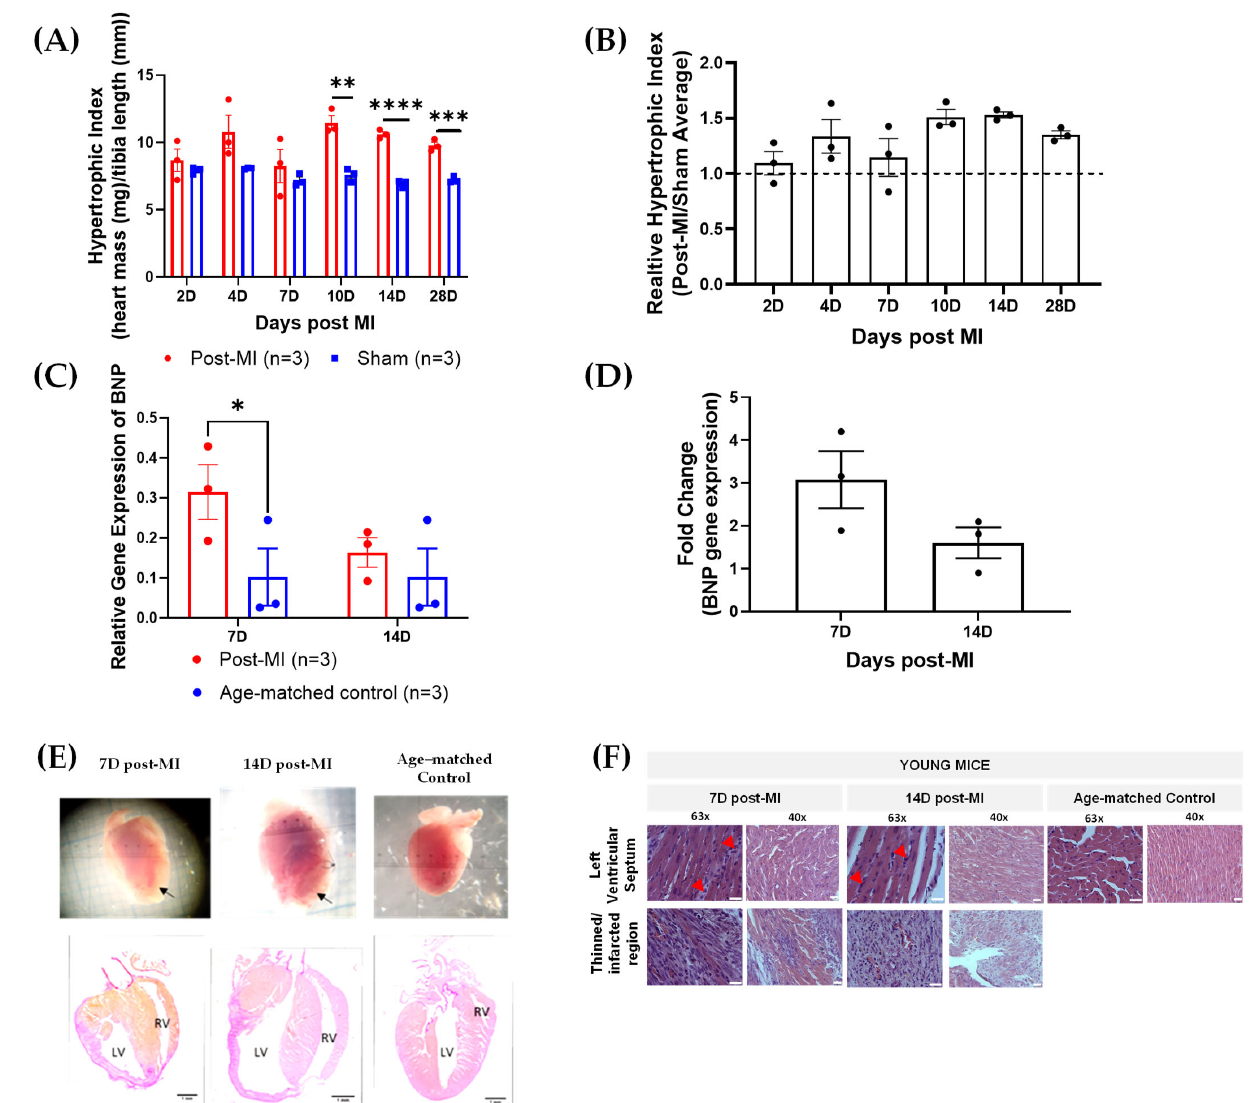
Figure 2. Physiological, biological and structural markers verifying HF progression. ( A ) Raw hyper- trophic indices of post-MI and sham groups between 2D and 28D post-MI. ( B ) Relative hypertrophic indices (post-MI/sham average) of post-MI groups between 2D and 28D post-MI. ( C ) Relative BNP gene expression levels at 7D and 14D post-MI and sham groups. ( D ) Fold changes in gene expression of post-MI populations with respect to their sham groups. Note: ‘ n ’ refers to the number of mice. Unpaired one-tailed t -test used to determine the differences between post-MI and sham groups. Note: * p < 0.05, ** p < 0.01, *** p < 0.001, **** p < 0.0001. ( B ) No significant differences among the means were verified using ordinary one-way ANOVA. ( E ) Heart images and histology (Van Gieson stain) of longitudinal heart sections show that the heart displays features of hypertrophic cardiomyopathy at both 7D and 14D post-MI and dilated cardiomyopathy at 14D post-MI. Black arrows point to the site of thinned left ventricular walls. Images are taken at 10 × magnification. Scale bar = 1 mm. Acronym: RV, right ventricle; LV, left ventricle; VS, ventricular septum. ( F ) H&E-stained, longitudinal heart sections at 7D and 14D post-MI and age-matched control, indicating post-MI features. Red arrows indicate site of inflammatory cell infiltration. Images were taken at 63 × oil immersion and 40 × magnification. Scale bar = 25 µ